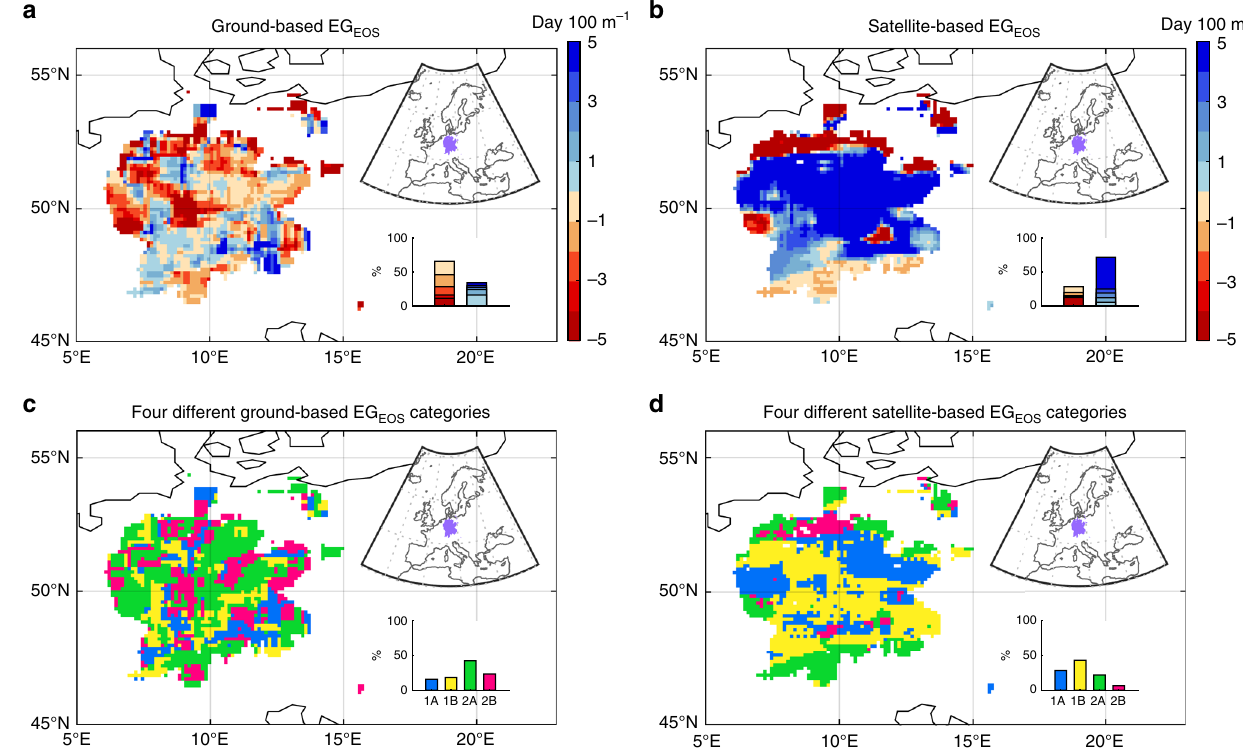
Fig. 6 Spatial patterns of the elevational gradient of EOS (EG EOS ) and their temporal trends. a The spatial pattern of ground-based EG EOS from 1982 to 2011. b The spatial pattern of satellite-based EG EOS from 1982 to 2011. Frequency distribution of the EG EOS values is shown in the inset at the bottom-right for each panel. c The spatial pattern of different categories of the temporal trends in ground-based EG EOS during 1982 – 2011. d The spatial pattern of different categories of the temporal trends in satellite-based EG EOS during 1982 – 2011. The area fraction of each of the four different categories in the temporal trends of EG EOS is shown in the inset at bottom-right for each panel. The location of the regions with European phenology stations is shown in the inset at top-right for each